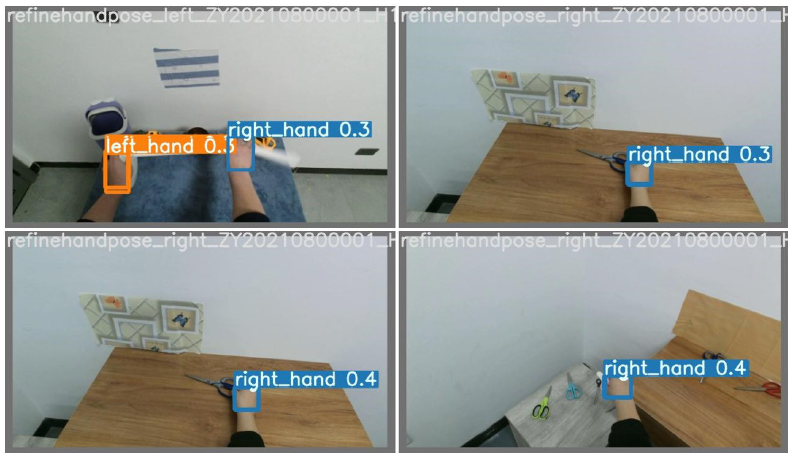
Figure 22. Illustration of hand classification results on the HOI4D